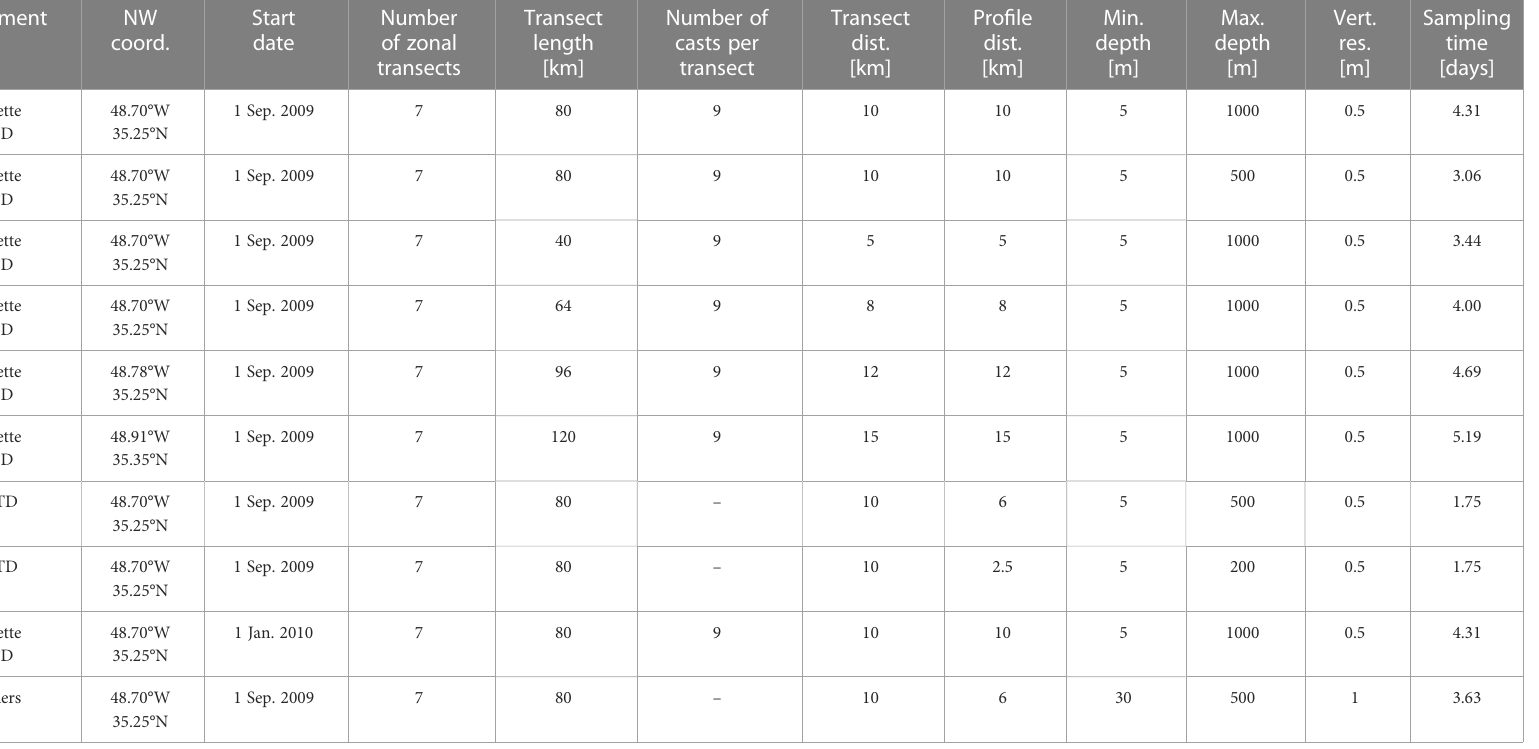
TABLE 2 Description of the con fi gurations simulated in the Atlantic study region. Con fi g. Instrument NW